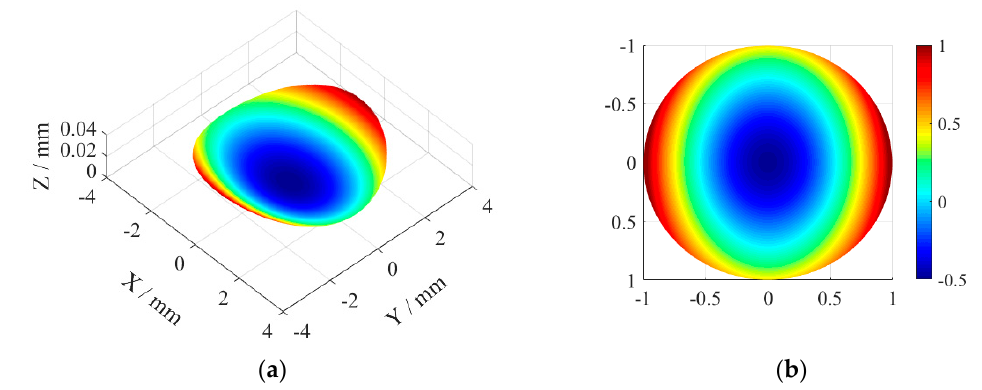
Figure 2. Under ideal conditions, toric surface’s ( a ) Three-dimensional topography map of the machined surface and ( b ) Wavefront map.